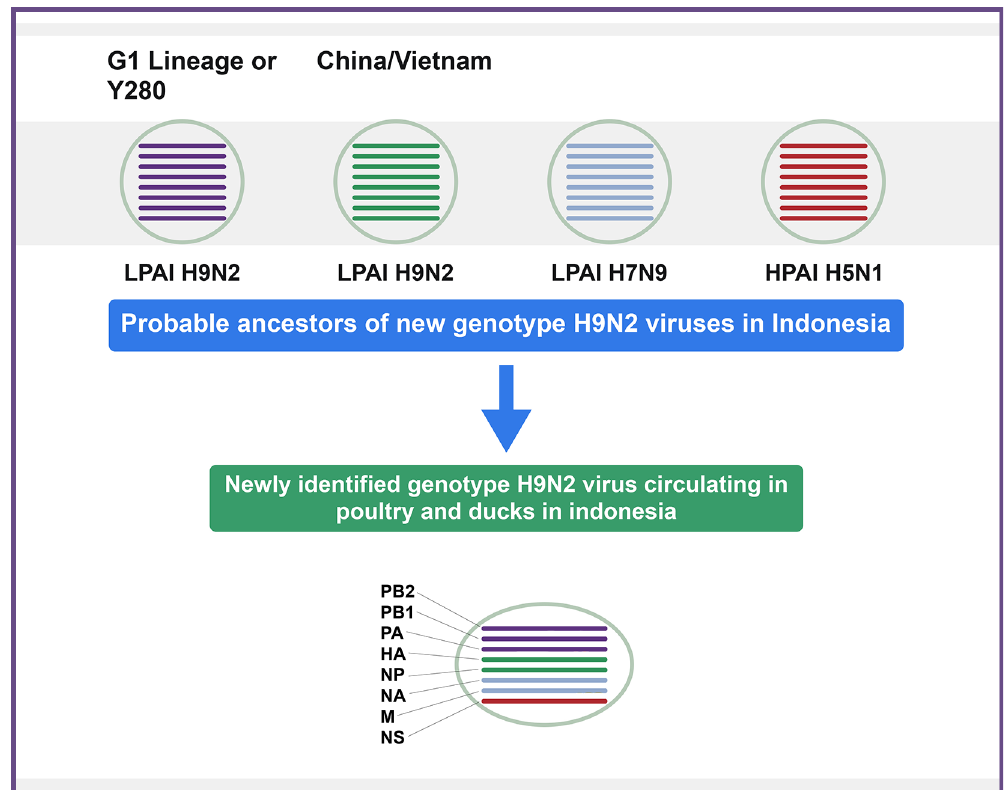
Figure 1. Representation of recently emerged H9N2 virus genotypes in poultry in Indonesia.